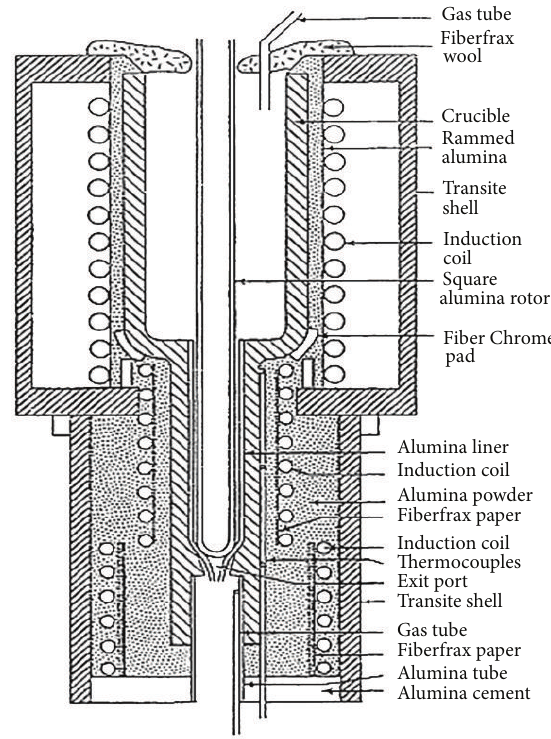
Figure 4: Schematic diagram of high-temperature continuous mechanical rheocaster [19].